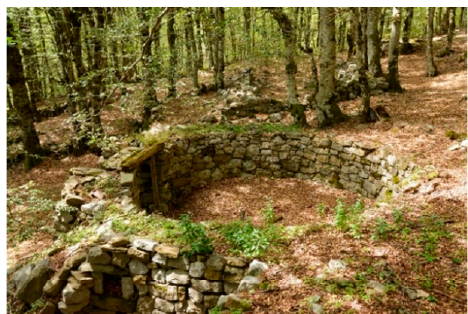
Figure 7. Katun in the forest—Crna Rupa, photo: I. Lakovi ć .